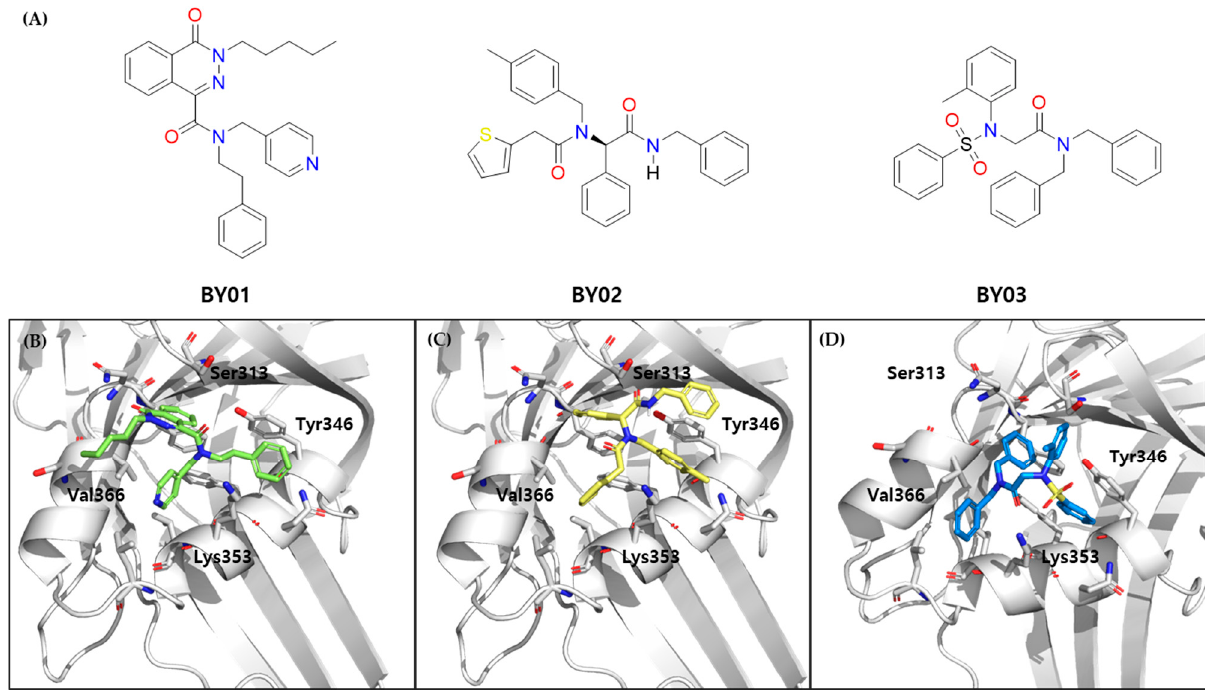
Figure 5. Structure of the three selected virtual hits from FMO-based virtual screening. ( A ) The structure of BY01, BY02, BY03. B. Docking poses in the TEAD1 binding pocket of BY01, ( B ); BY02, ( C ) and BY03, ( D ) using Glide in the Schrödinger suite.